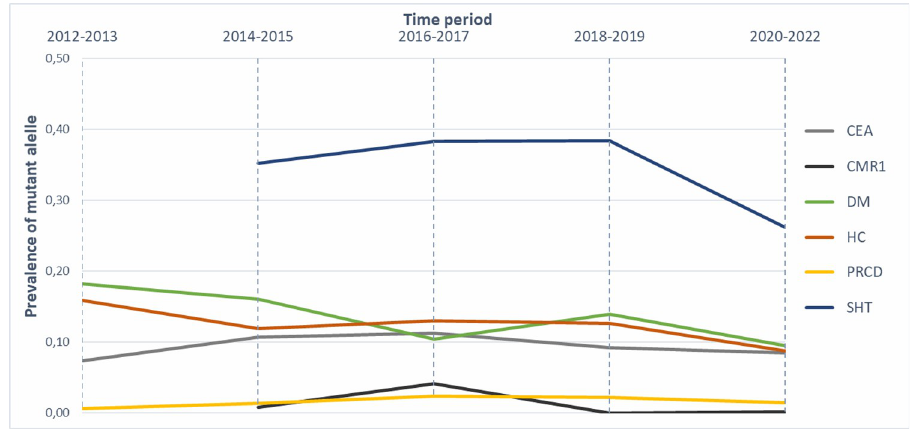
Fig 1. The trends in incidence of the six diseases in the AS breed. The time period: 2012–2022. Each coloured line represents the incidence of the mutant alleles in CEA, CMR1, DM, HC, PRCD and SHT diseases over two-year